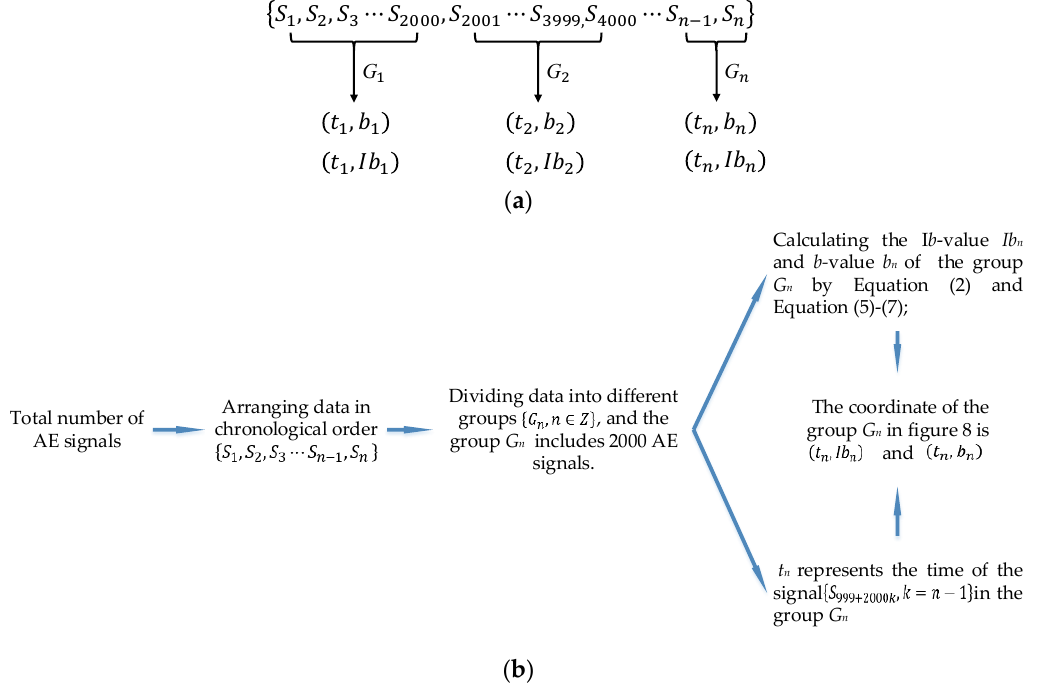
Figure 7. The flow chart of b -value method and Ib -value method: ( a ) the process of dividing signals into different groups; ( b ) the calculating process.